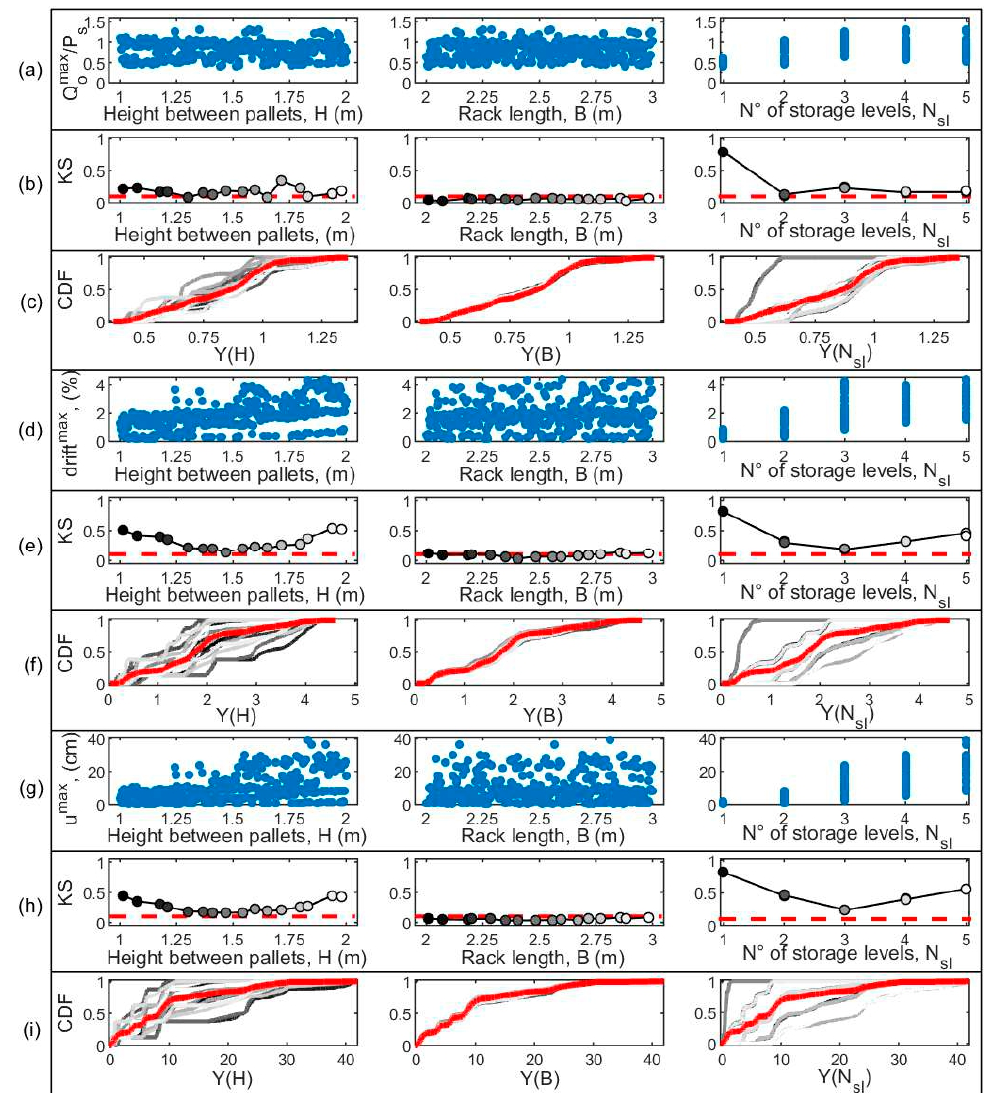
Figure 8. Scatterplot, Kolmogorov-Smirnov Statistics (KS) and conditional and unconditional CDFs of the target responses. Rows ( a – c ) are for the maximum base shear load ( Q max o ) normalized by the seismic weight ( P s ); ( d – f ) are for the drift; and ( g – i ) are for the maximum displacement of the top of the FBR ( u max